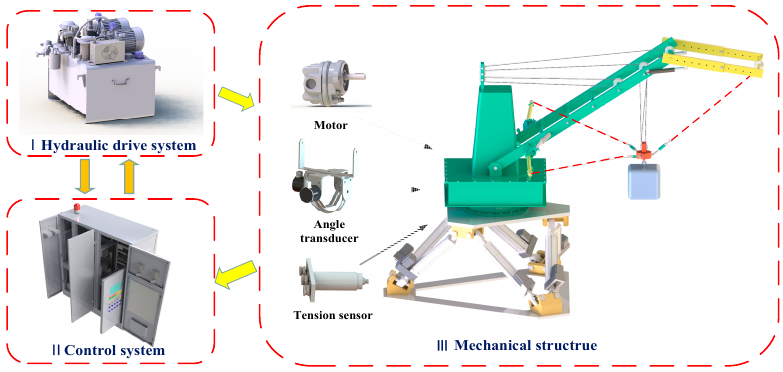
Figure 1. Schematic diagram of the TTAS.